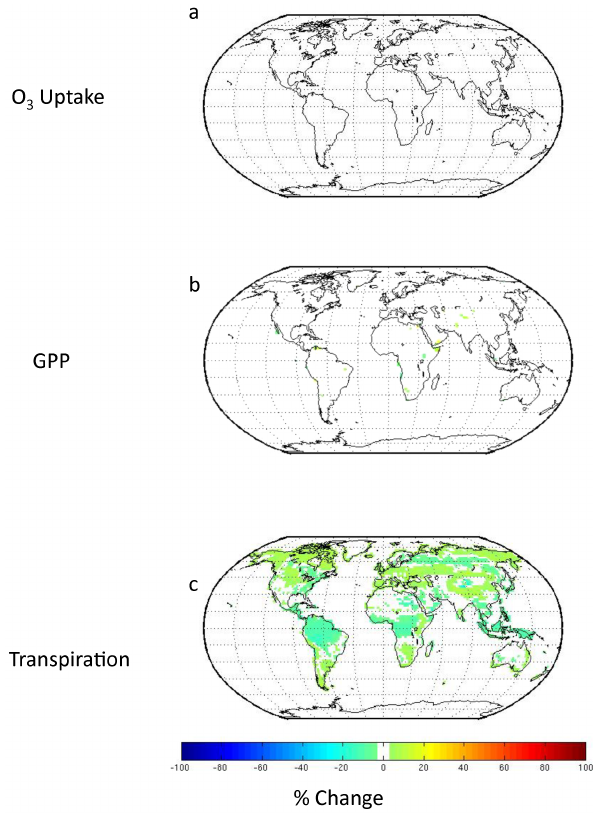
Fig. 9. A sensitivity analysis comparing the PG and Pg simula- tions at the same O 3 uptake rate. The differences in O 3 uptake (a) , GPP (b) , and transpiration (c) between the PG compared to the Pg simulation, mapped as a percent change from control in pan- els (b) and (c) . Annual means were calculated from a single-year CLM simulation where O 3 uptake was set at a constant rate of 3mmolm − 2